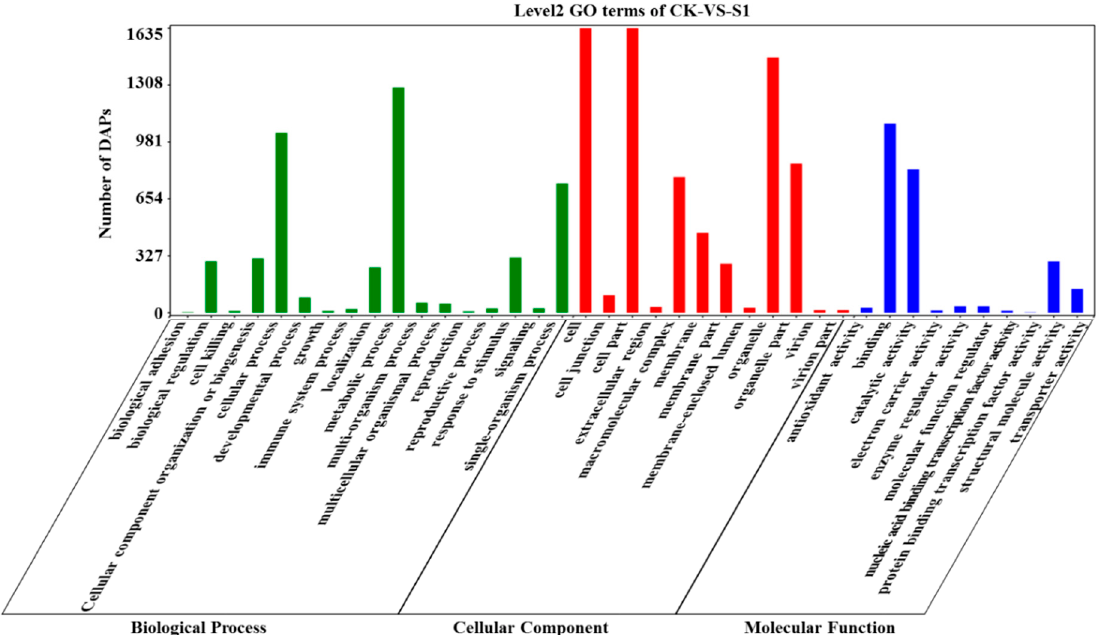
Figure 2. Gene ontology (GO) classifications of the differentially accumulated proteins (DAPs) identified in isobaric tags for relative and absolute quantification (iTRAQ) of Pst -infected wheat leaves at 24 hpi. The level2 GO terms are shown below each bar, while ontology classes biological process, Cellular component and molecular function are represented by green, red and blue bars, respectively. The number of DAPs was shown as the ordinate.